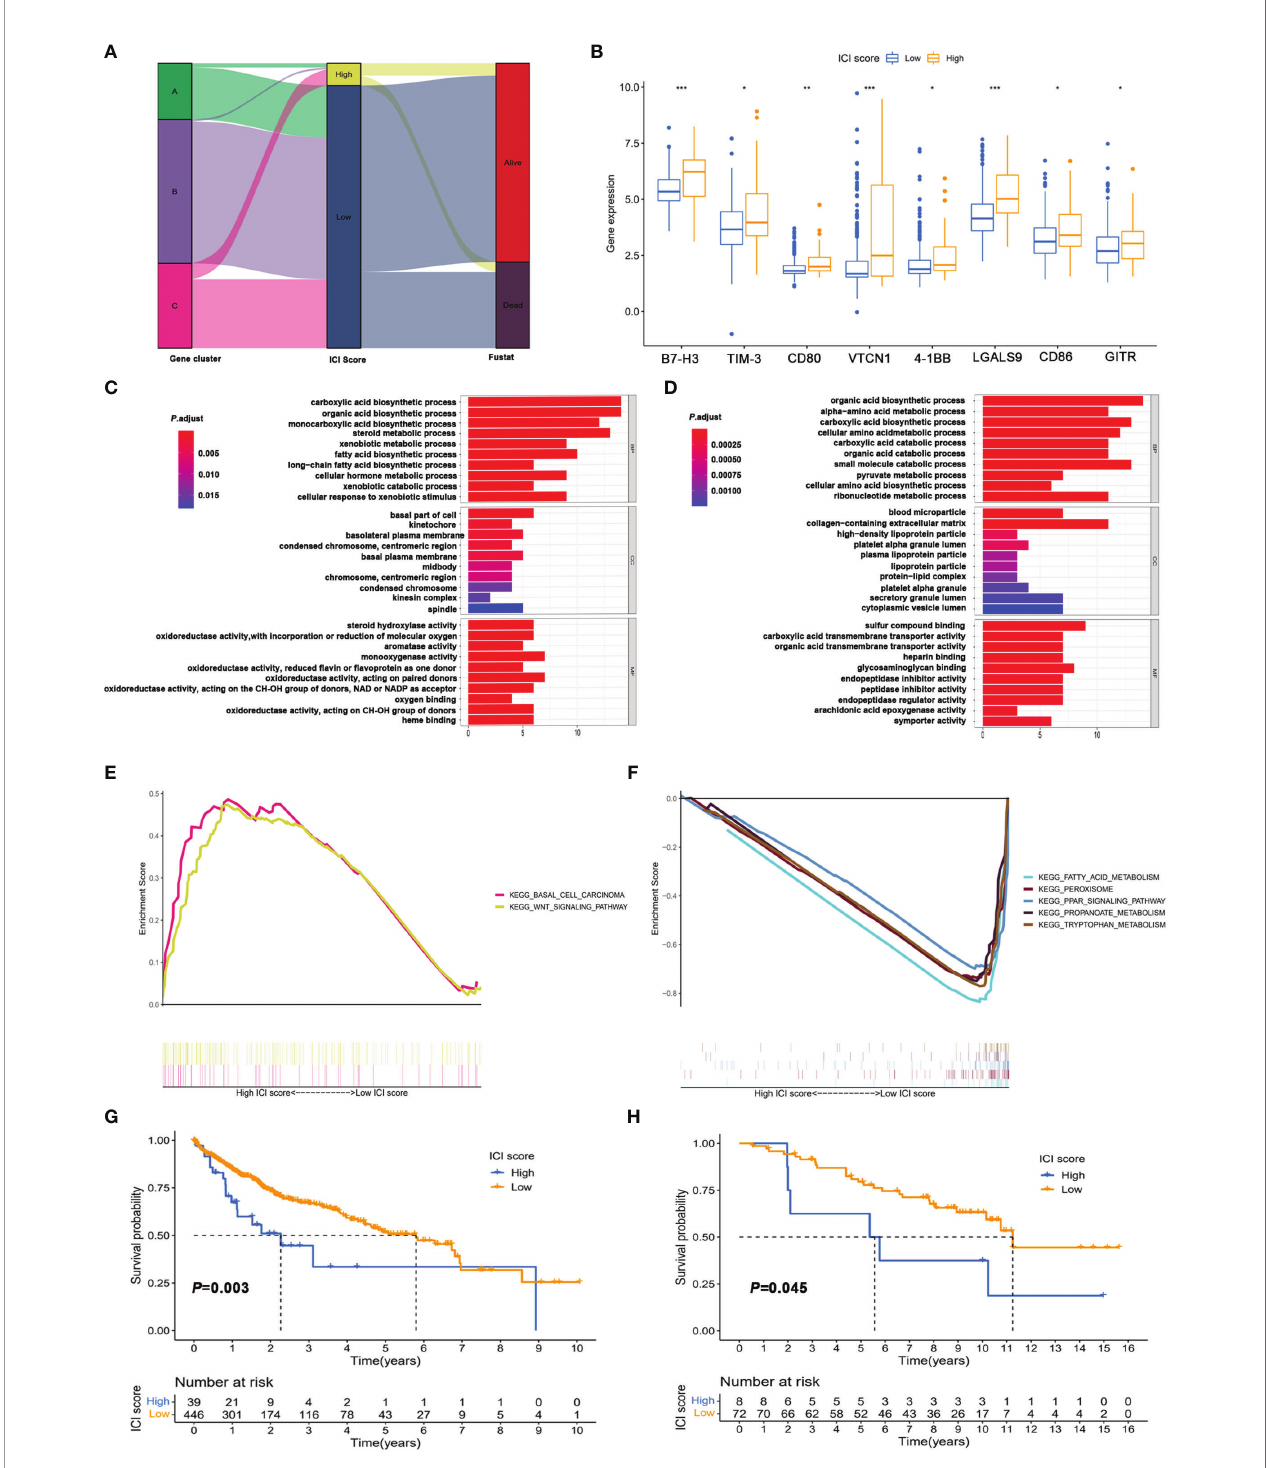
FIGURE 4 | Construction of immune score and functional enrichment analysis based on immune in fi ltration-related genes. (A) Alluvial plot of distribution of the ICI score and prognosis in different immune in fi ltration gene clusters. (B) Expression of immune checkpoint in high and low ICI score groups. * p < 0.05; ** p < 0.01; *** p < 0.001; ns, not signi fi cant. (C, D) GO enrichment analysis of signature genes A (C) and B (D) . (E, F) Gene set enrichment analysis (GSEA) of high score (E) and low score group (F) . (G) Kaplan – Meier survival analysis of high score and low score groups divided based on the optimal cutoff value. (H) Kaplan – Meier survival analysis of high score and low score groups in the validation cohort